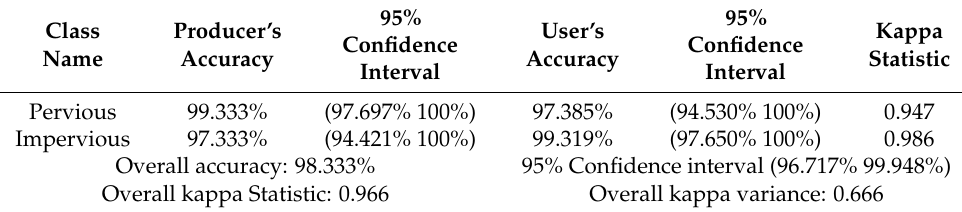
Table 4. 2018 Error (confusion) matrix.